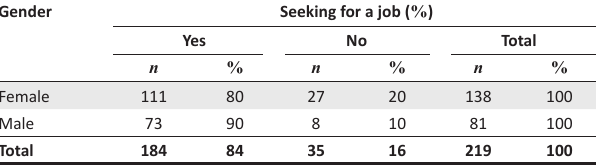
Pearson chi 2 = 3.568; p =